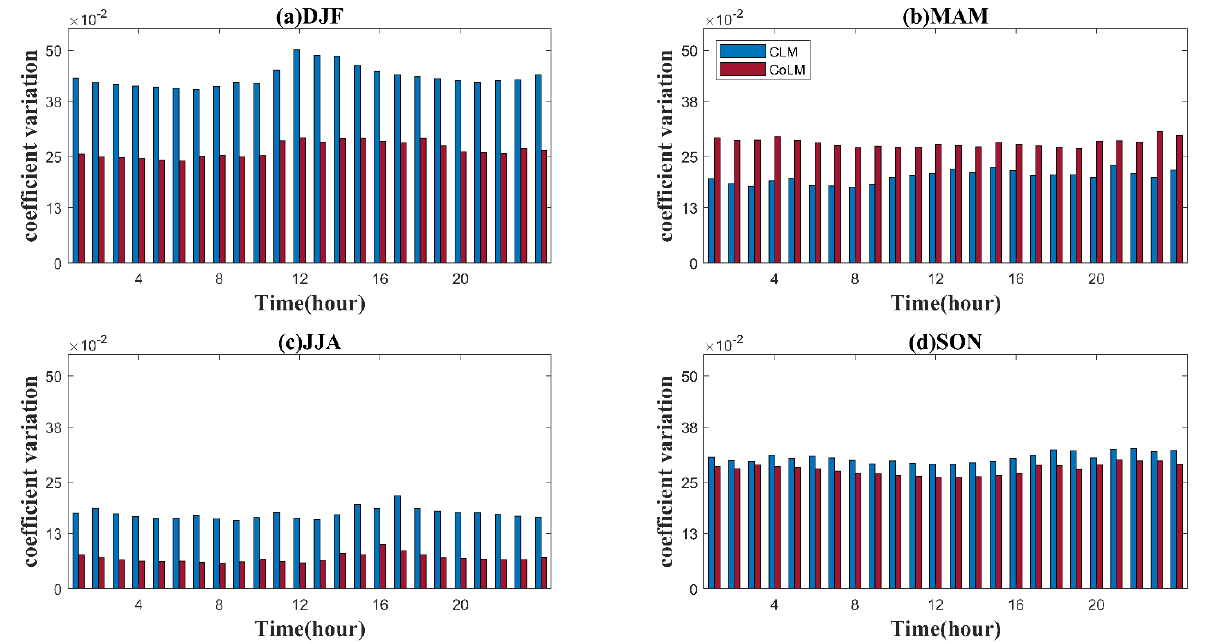
Figure 8. The shallowest layer’s coefficient of variation of diurnal simulations at the Little River site, with CLM5 simulations in blue bars and CoLM2014 simulations in red bars, for ( a – d ) winter, spring, summer, and autumn, respectively.